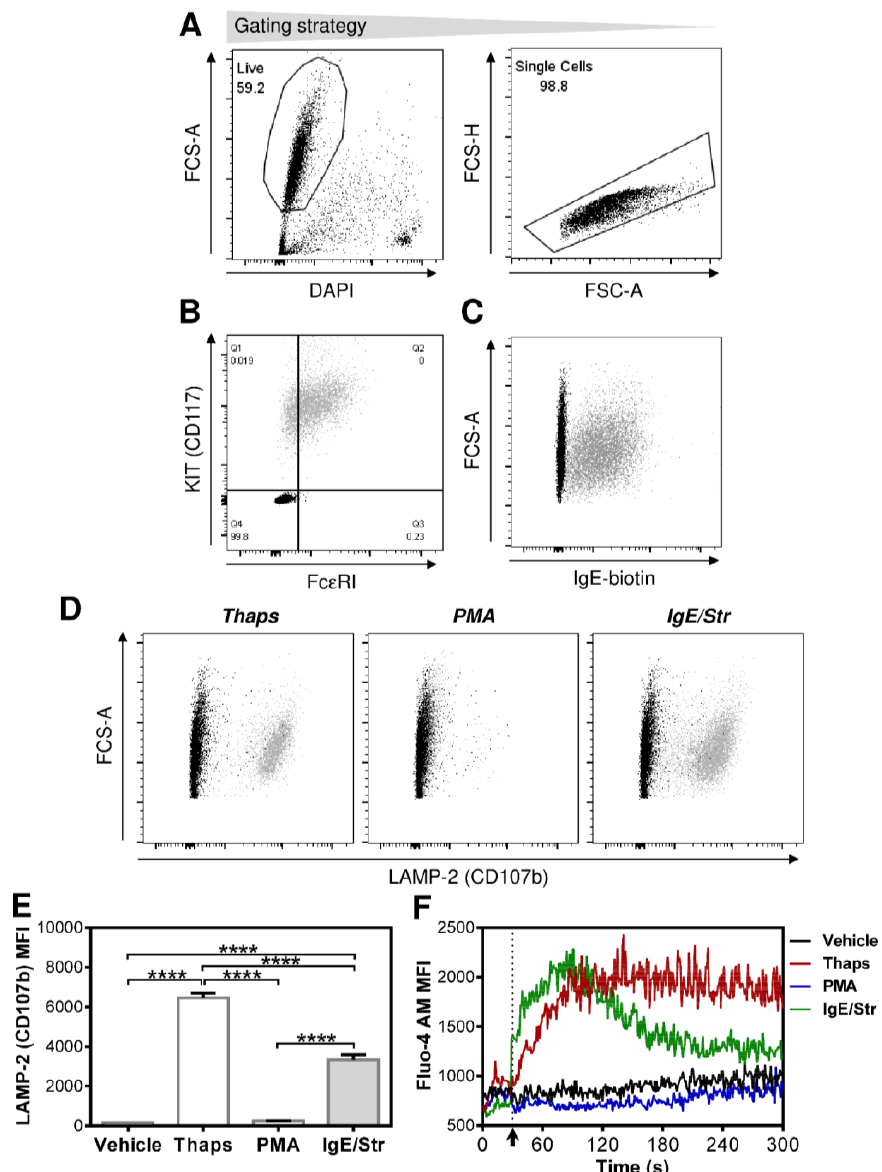
Figure 1. LAD2 mast cell (MC) phenotype and responses to differential stimulation. ( A – B ) LAD2 MCs were